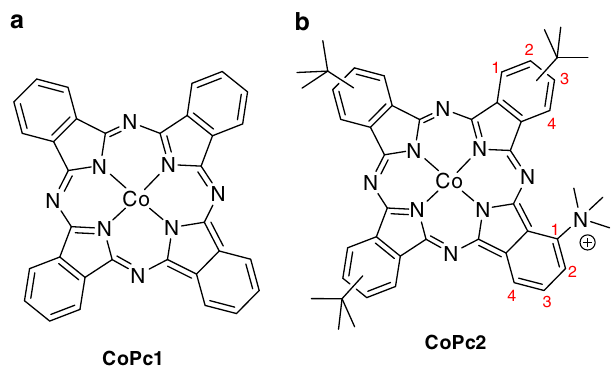
Fig. 1 Cobalt phthalocyanine catalysts CoPc1 and CoPc2 investigated in this study. a CoPc1 bears no substituents. b CoPc2 bears one trimethyl ammonium group at position 1 of the isoindole subunits, and three tert -butyl groups (positions 2 or 3) of the other